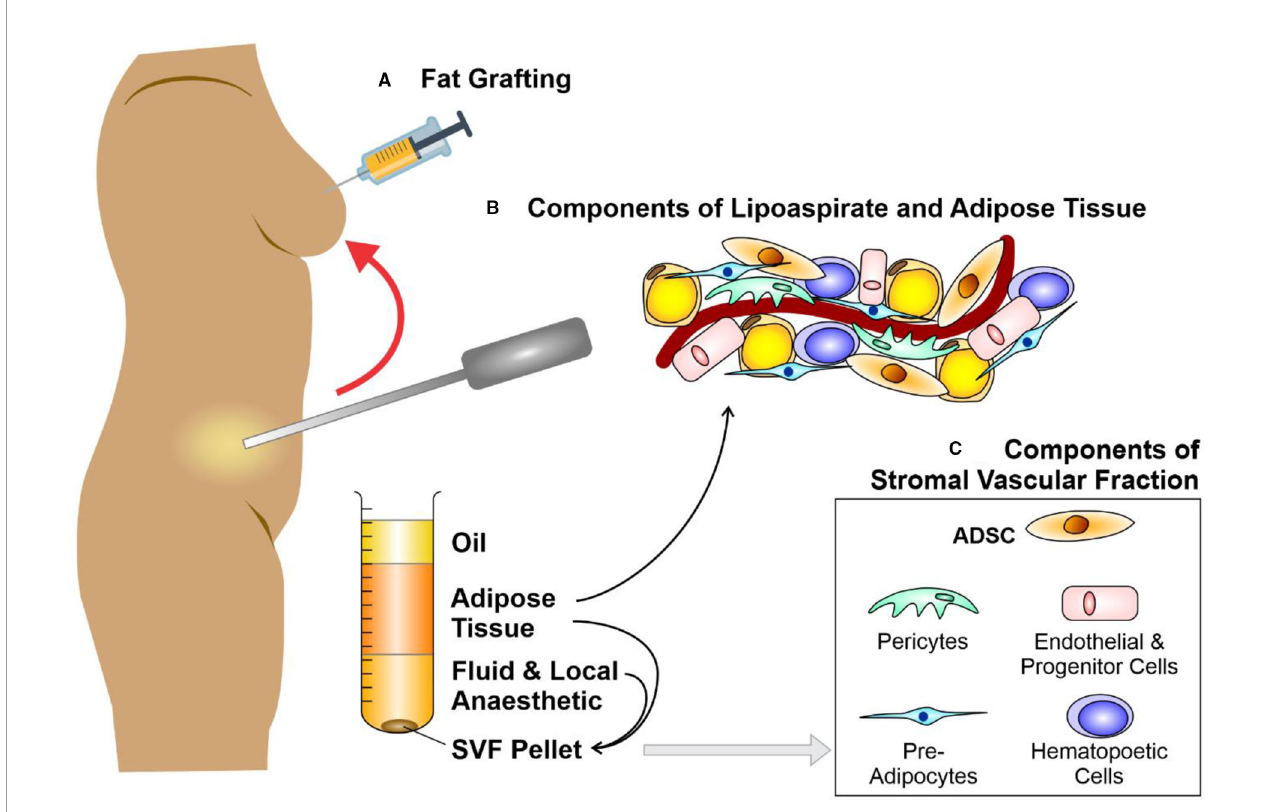
FIGURE 1 | Liposuction, fat grafting and the components of adipose tissue. Schematic diagram depicting (A) fat grafting after liposuction of subcutaneous fat from an abdominal donor site. The components of lipoaspirate (B) separate into layers of oil (discarded), aspirated adipose tissue and infranatant (composed of blood, plasma, and local anesthetic). The components of adipose tissue and the key constituents of the stromal vascular fraction (SVF) pellet (C) may be re-introduced to enhance the fat graft. Further processing of this adipose tissue with collagenase digestion and centrifugation allows the isolation of a SVF pellet. Figure adapted from Shukla et al. (2015) under the CC-BY license (Shukla et al.,